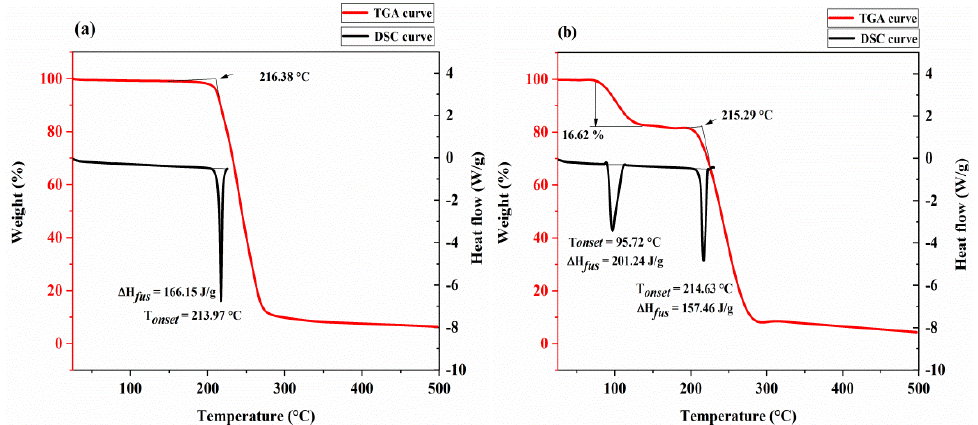
Figure 7. Thermal analysis of the desolvate ( a ) and the solvate ( b ) of Met–Bar. The red and black lines represent the TGA and DSC curves,